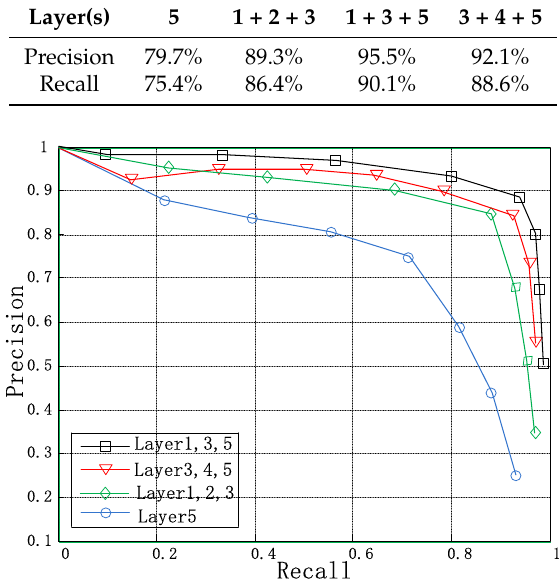
Figure 5. Precision-recall curves of the network obtained by fusing the features of different layers.